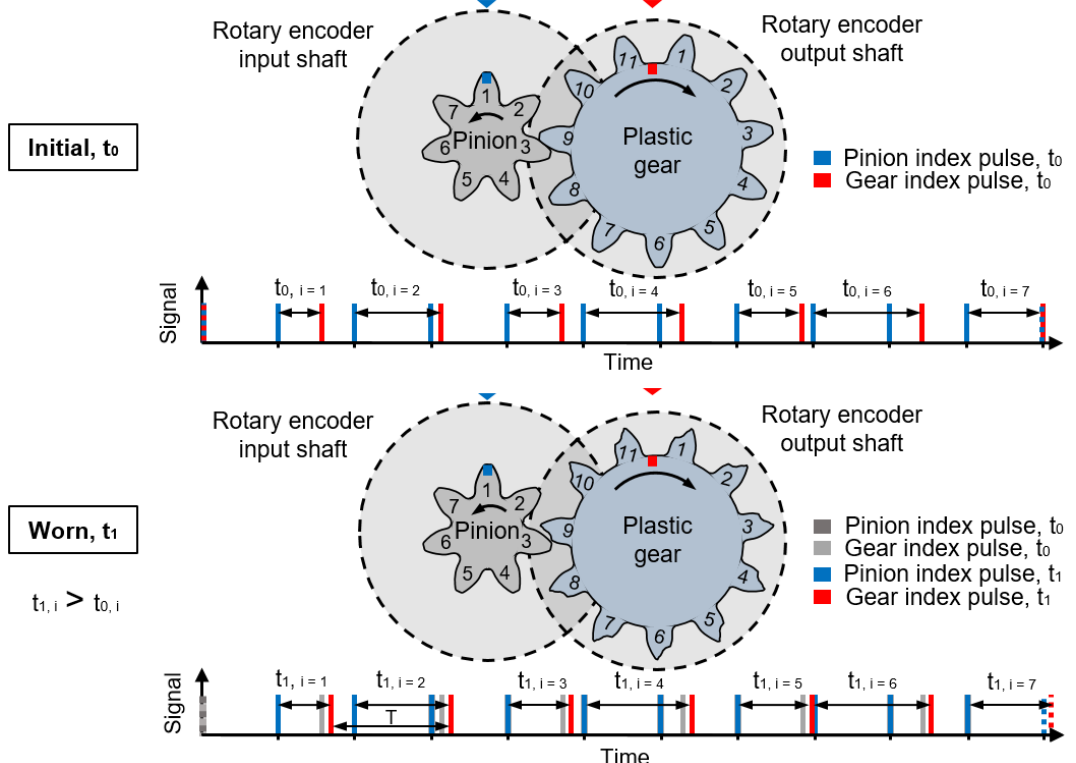
Figure 3. Tooth wear induced change of the timing difference between input and output index